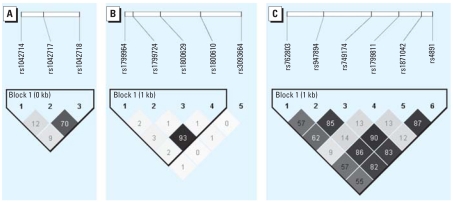
Block structure and correlation of the SNPs in the ADRB2 gene (A), TNF gene (B), and GSTP1 gene (C). We defined the block structure based on the LD coefficient D′ using Haploview (solid spine of LD) (Barrett et al. 2005). The numbers in each box correspond to the pairwise correlation coefficient r2 between respective SNPs.